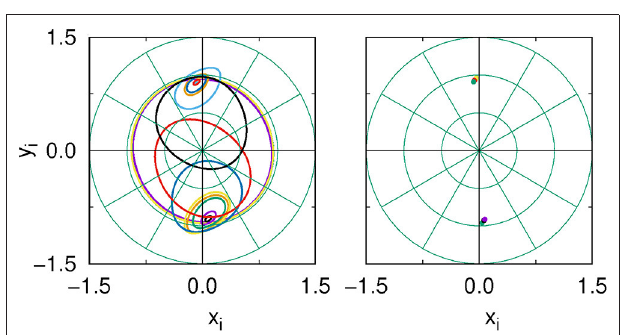
FIGURE 2 | Without filtering: Phase-space plot of a few nodes of the network from the coherent and incoherent domains (Left panel) AC ( ε in Figure 1A ), and (Right panel) OD ( ε parameter values are P